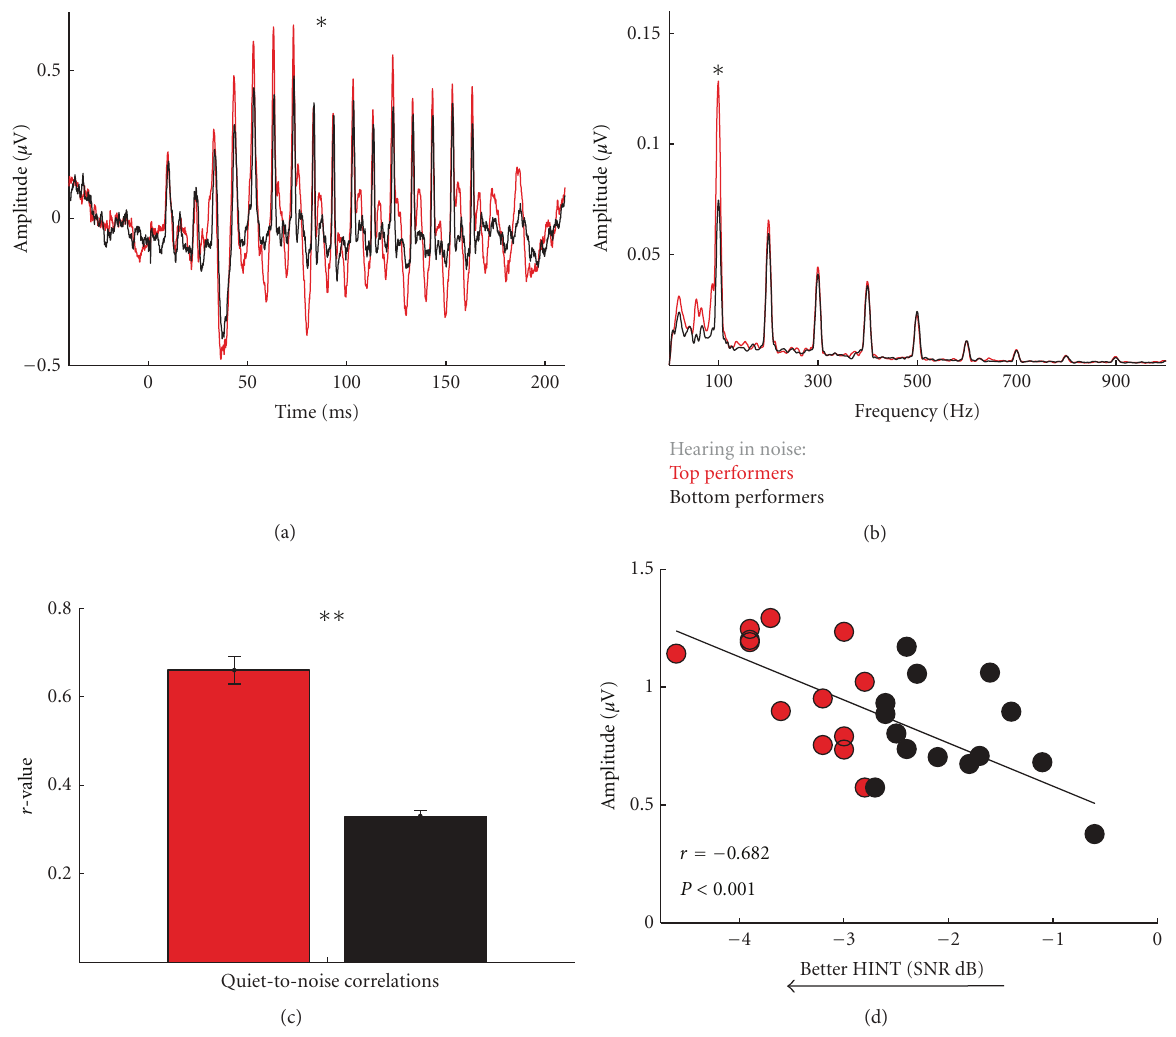
Figure 3: Responses to the syllable /da/ are more robust in older adults with good speech-in-noise perception compared to those with poor speech-in-noise perception, demonstrated by greater RMS amplitude (a) and amplitude of the 𝐹 0 in the good speech-in-noise group (b). The responses in the poor speech-in-noise group were more susceptible to the degrading effects of noise, as shown by greater differences in responses to the /da/ in quiet and noise (cross-correlations) (c). Relationship between speech-in-noise perception and the quiet-noise correlation (d). ∗ 𝑃 < 0.05 , ∗∗ 𝑃 < 0.01 . Modified from